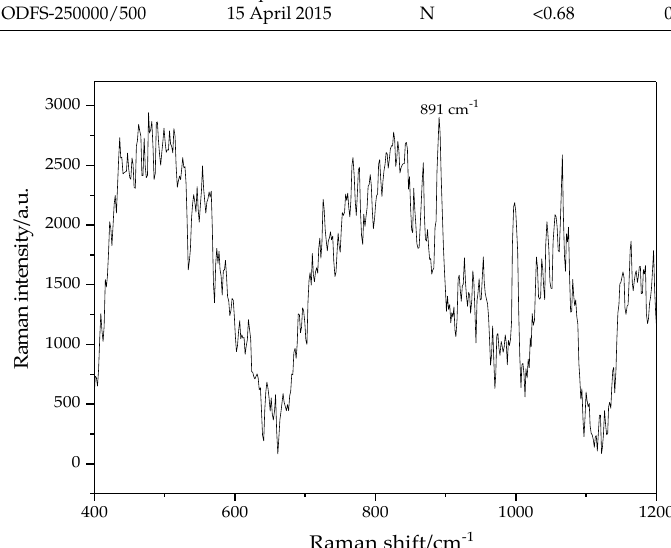
Figure 10. Raman spectrum of transformer oil from an operating transformer of Longjing of the Chongqing Electric Power Company, State Grid of